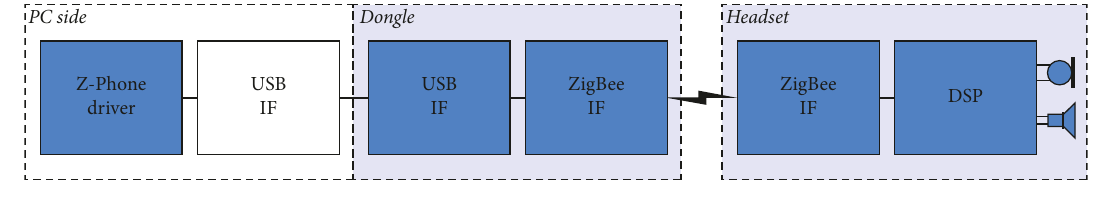
Figure 3: Z-Phone software/firmware